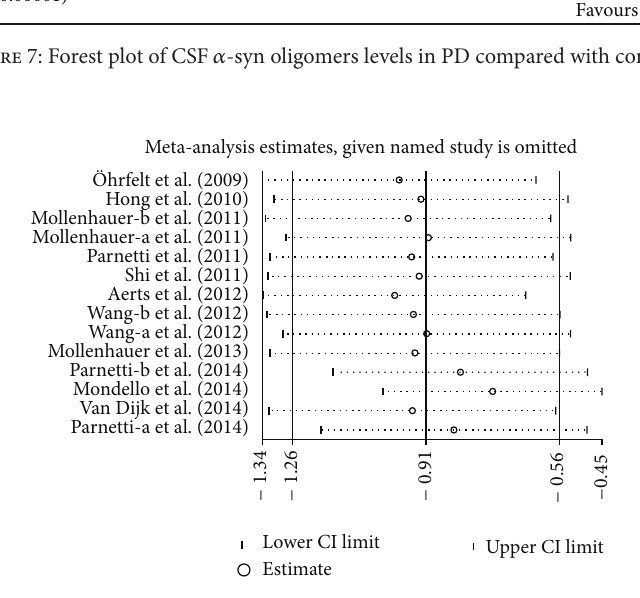
Figure 8: Sensitivity analysis of CSF 𝛼 -syn levels in PD compared to